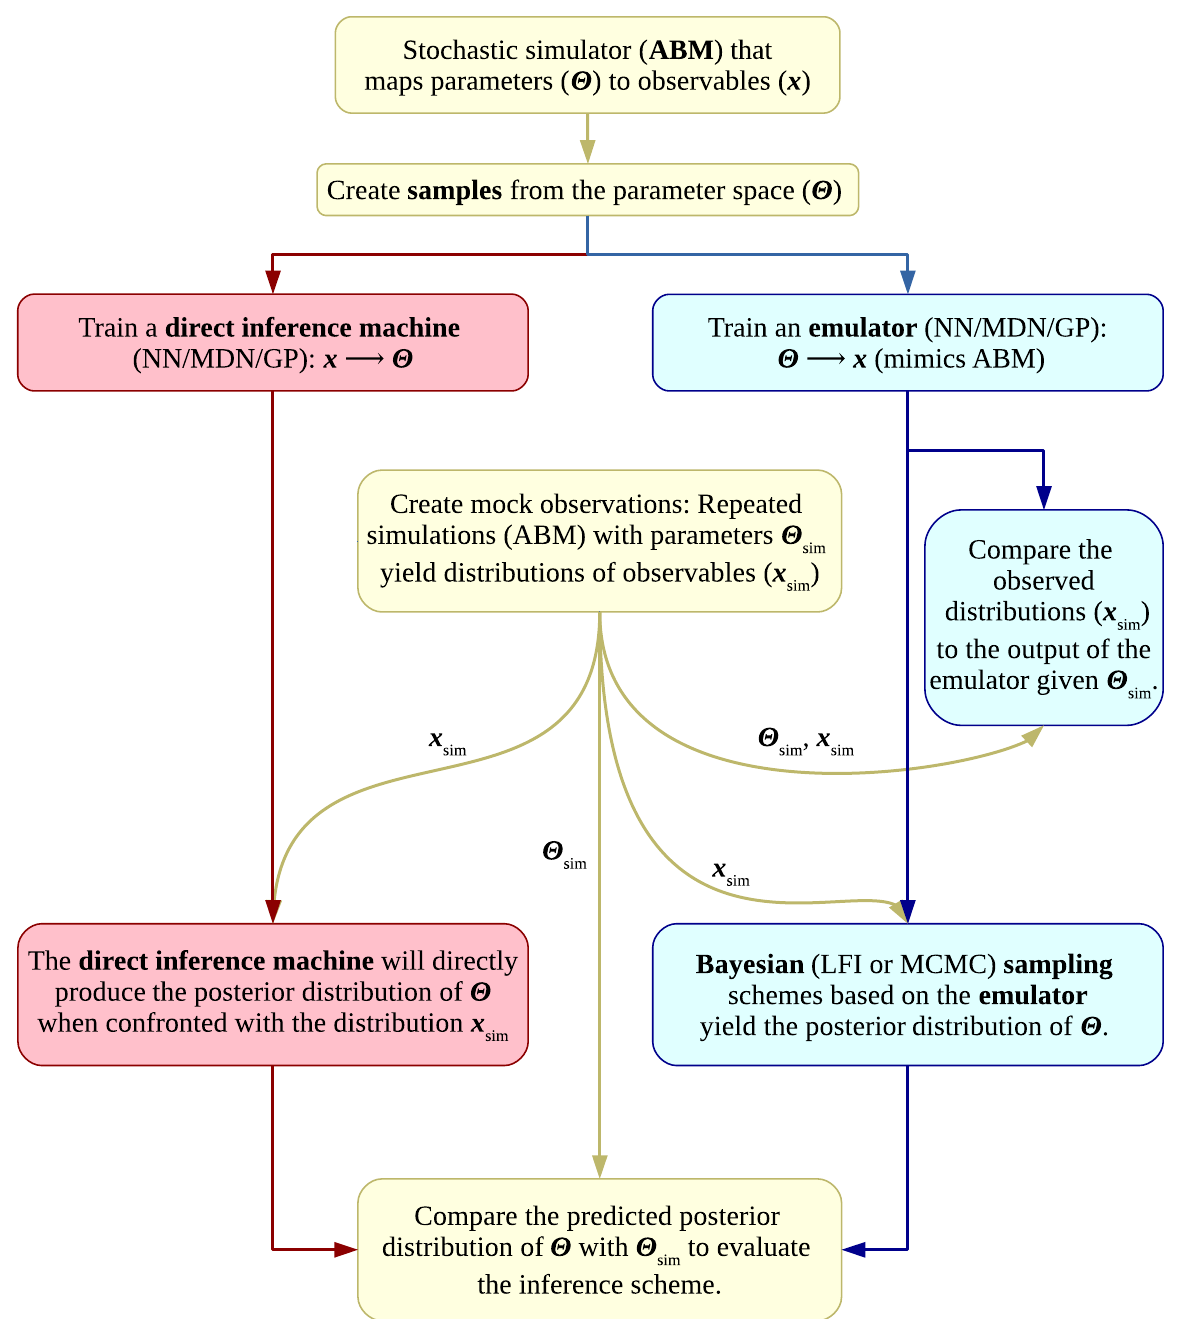
Fig 1. Flowchart summarizing the different steps of our analysis. We sample the parameter space by creating quasi-random grids of simulations using the agent-based models (ABM). We then employ the sampled parameter sets ( Θ sim ) and the simulation output ( x sim ) to train different machine learning (ML) methods: Neural networks (NN), mixture density networks (MDN) and Gaussian processes (GP). These ML methods can either be used as emulators or direct inference machines. Emulators mimic the simulations at low computational cost. They can be employed in Bayesian sampling schemes, such as MCMC and Likelihood Free Inference (LFI), to infer model parameters based on the observations. Direct inference machines can be seen as black boxes that produce samples from the posterior distribution of model parameters when given the observations. We use synthetic data obtained from the ABM which allows us to compare the obtained posterior distributions for the model parameters with the ground truth. For both the emulators and direct inference machines, we thus perform a classical inference task, amounting to a self-consistent test. Moreover, we quantify how well the emulators capture the behaviour of the ABMs in separate comparisons.